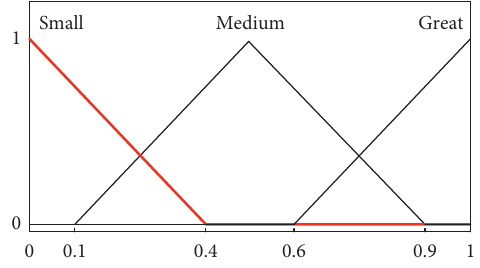
Figure 21: FV membership functions for LV m